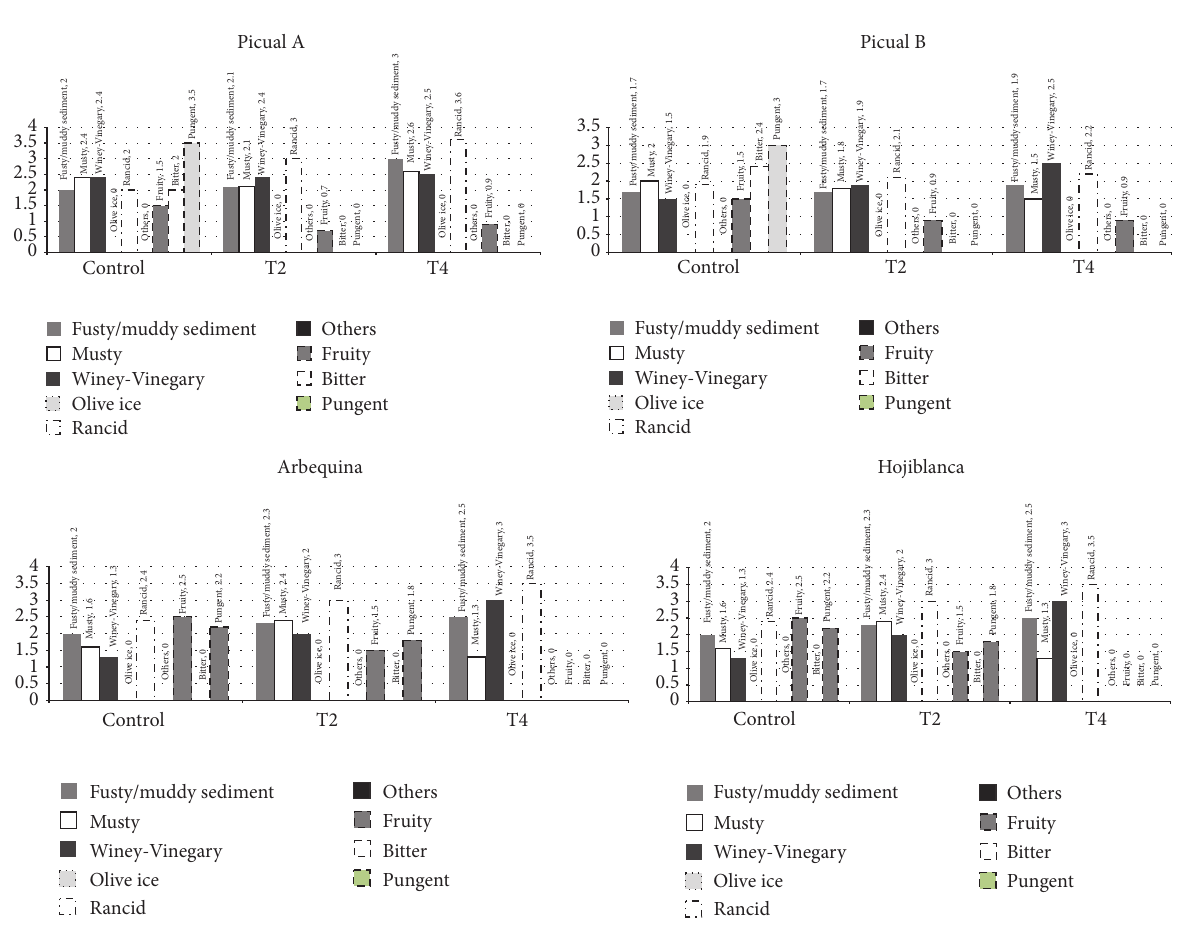
Figure 3: Influence of the heating treatments on the sensory analysis. Positive features and